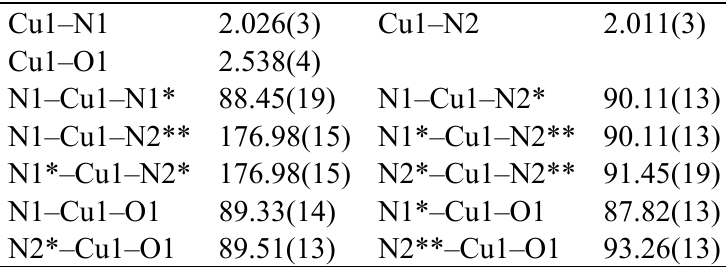
Table 1. Selected bond lengths (Å) and angles (°) of 1